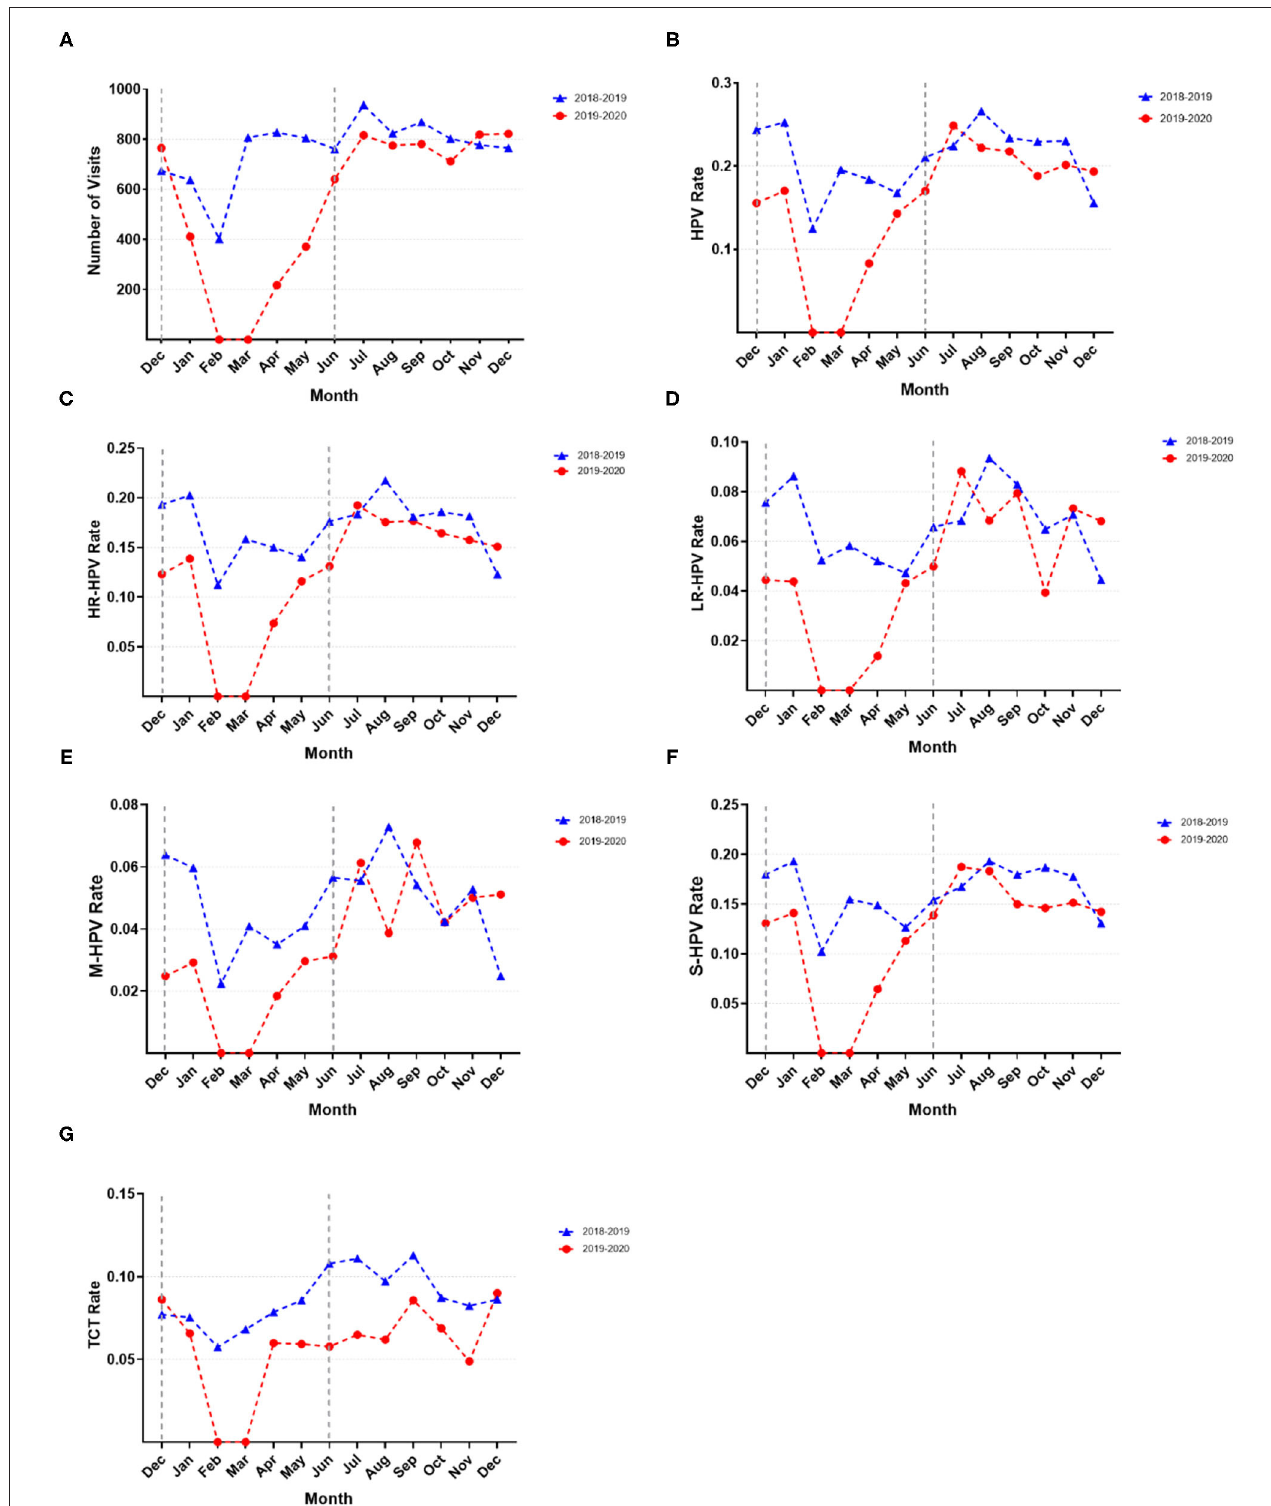
FIGURE 2 | Monthly comparison of HPV screening visits and infection rates. (A) Visit number per month; (B) HPV infection rate; (C) HR-HPV infection rate; (D) LR-HPV infection rate; (E) M-HPV infection rate; (F) S-HPV infection rate; (G) TCT abnormal rate.